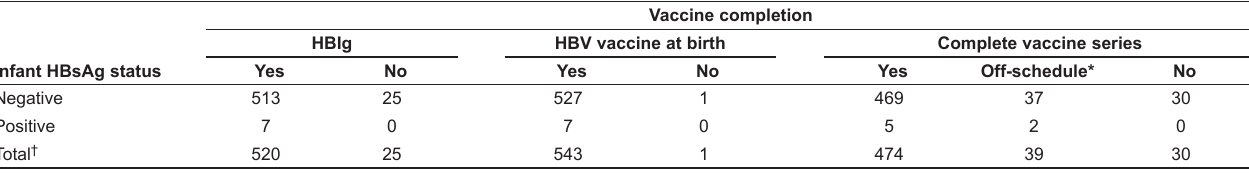
Table 3 Infant hepatitis b surface antigen (Hbsag) status and vaccine receipt